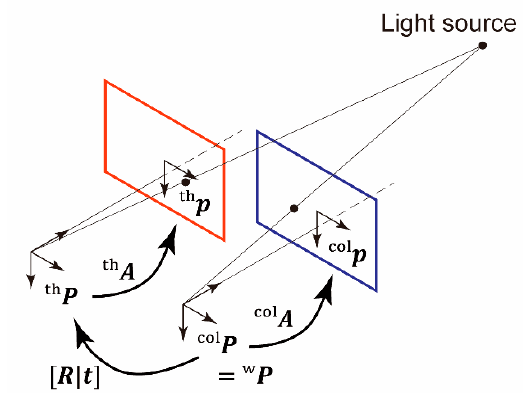
Figure 5. Relationships among world, thermal camera, color camera, thermal image, and color image coordinate systems.